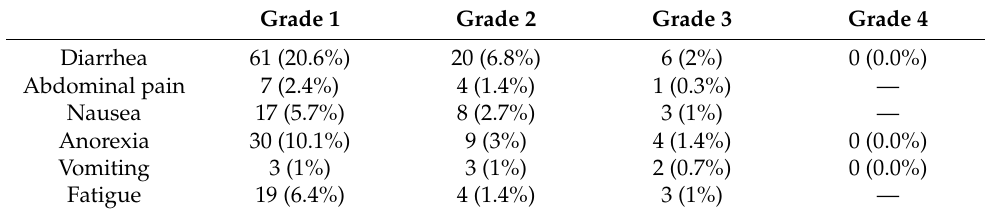
Figure 2. Frequency of bowel movements after naldemedine intake. Table 3. Adverse events considered to be associated with naldemedine use.